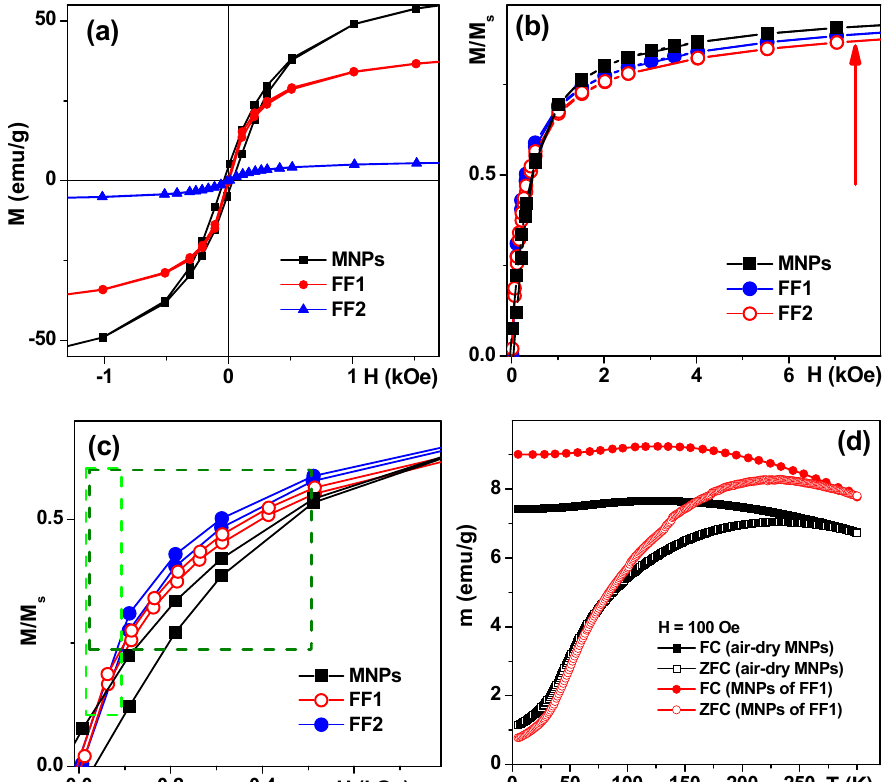
Figure 3. ( a )—Hysteresis loops of LTE MNPs, FF-1, FF-2 suspensions at room temperature. Recalculated M/M s hysteresis loops for M s —being a saturation magnetization values corresponding to each particular case ( b , c ), red arrow shows the direction of the increase of the magnetization; ( c )—dashed lines show two important intervals for possible applications: light green—magnetic biosensing interval; green—cell use as native microcapsules for targeted delivery in a supplement of nanomedicine, theranostics, cell technologies, and regenerative medicine; ( d )—ZFC-FC curves for air dry LTE MNPs and MNPs of FF1.